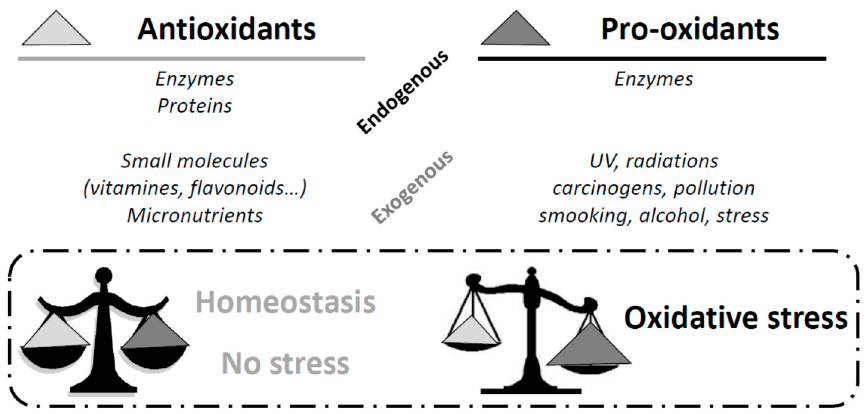
Figure 4. Oxidative stress: A question of balance.